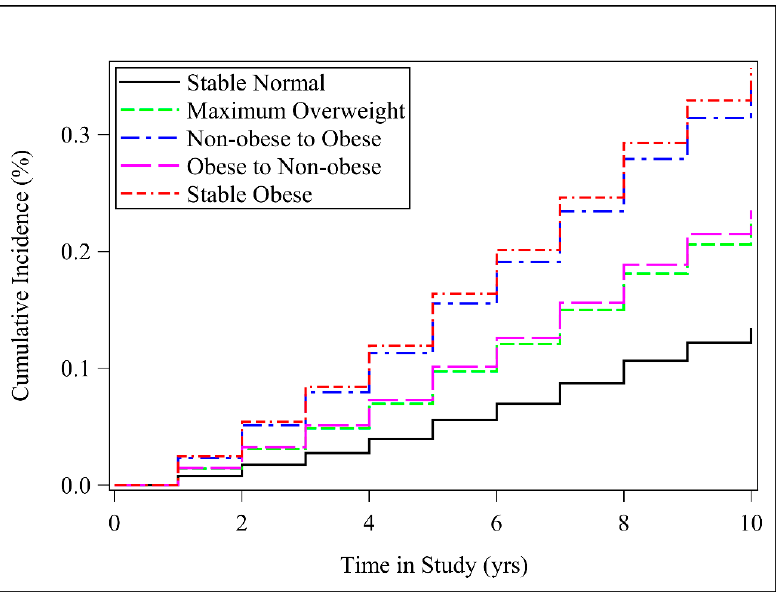
Figure 1. Cumulative incidence curve for hypertension by weight change category. Multivariable Cox regression model adjusted for sex, baseline age, race / ethnicity, family income, education, and smoking